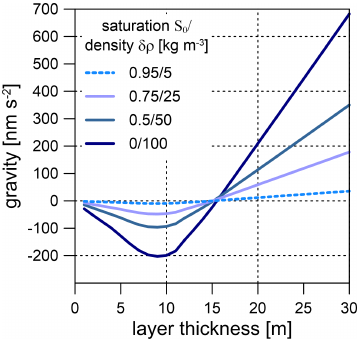
Figure 12. Modelled gravity of a layer with constant thickness as function of the layer thickness and the degree of initial soil/rock saturation (for an explanation, see the